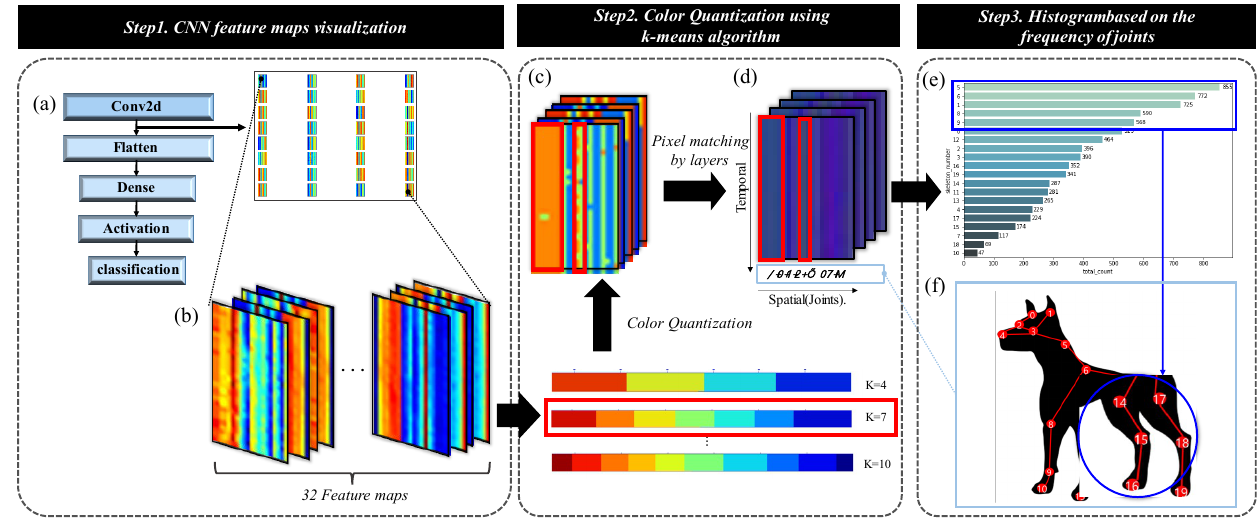
Figure 5. Histogram-based backtracking algorithm through RGB color representation: ( a ) Structures of CNN Networks(step3 of Figure 2), ( b ) 32 feature maps in each layer, ( c ) Generated images through a color quantization method using K-means clustering, ( d ) The values of the pixels corresponding to the extracted positions are mapped to the respective RGB channels and the skeleton matrix, ( e ) The histogram according to the joint frequency is produced based on the extracted joint names and numbers and ( f ) Joints that influence the model’s decision on the behavioral image are extracted.